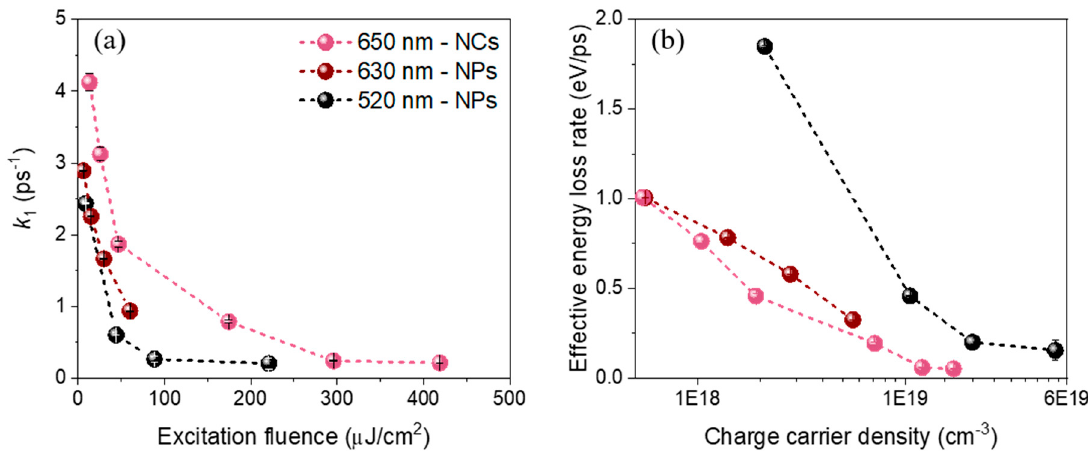
Figure 4. ( a ) Extracted cooling rates k 1 of FAPbI 3 NCs (pink dots, excitation 650 nm) and thick NPs (excitation 630 nm: wine-colored dots, excitation 520 nm: black dots) plotted versus the excitation fluence. ( b ) Plot of the corresponding energy loss rate versus the charge carrier density (number of initial electron-hole pairs per nanocrystal volume).